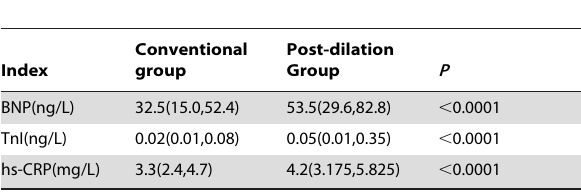
Table 7. Post-procedural levels of BNP, TnI and hs-CRP between both groups